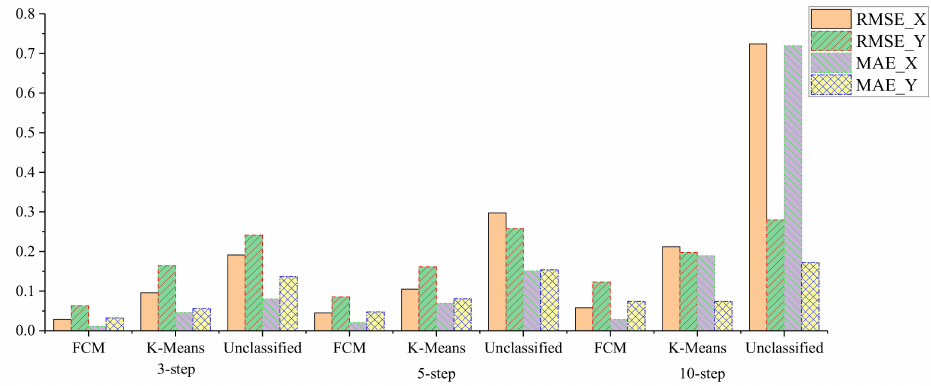
Figure 5. Comparison figure of multistep prediction error.